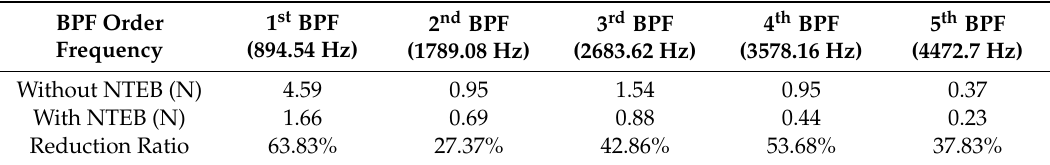
Figure 6. Blade-passing frequencies of axial thrust. Table 1. The first five orders of blade-passing frequencies (BPF).